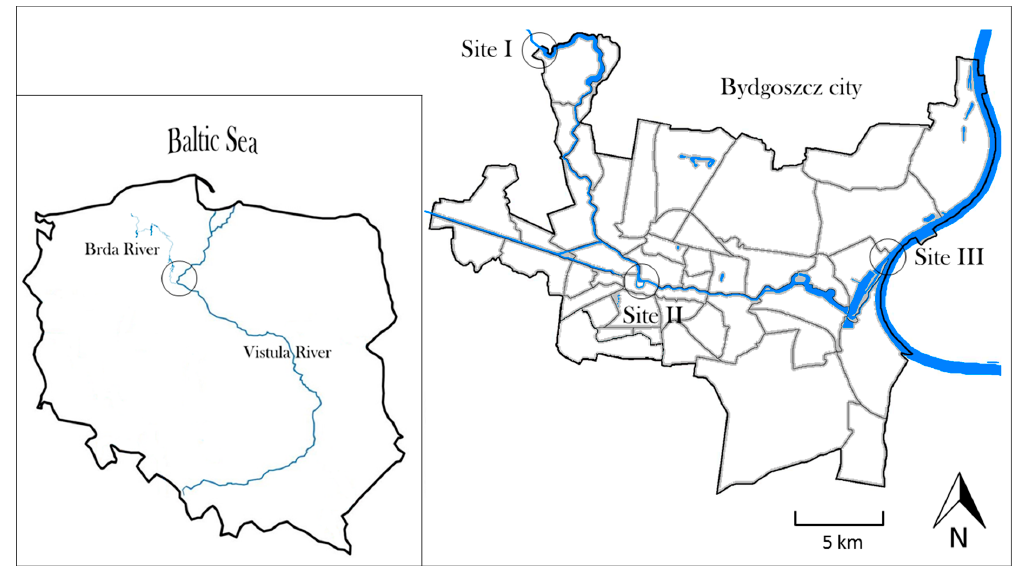
Figure 1. Arrangement of the sampling sites. The rivers are marked in blue.